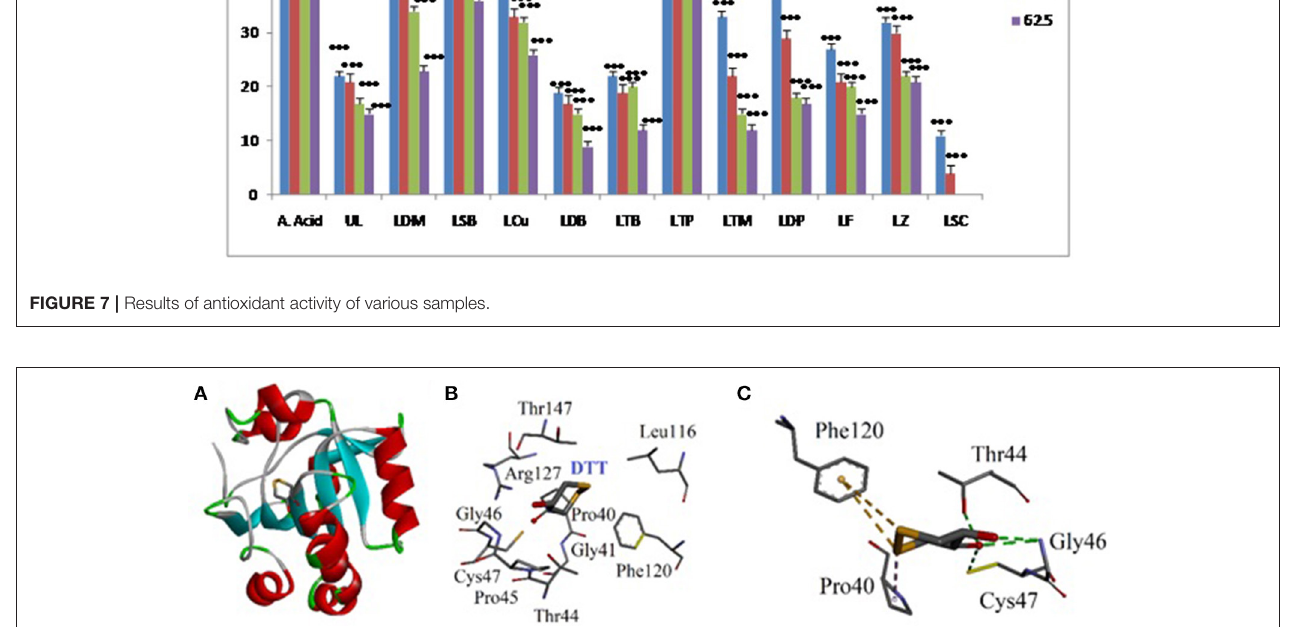
Frontiers in Chemistry |